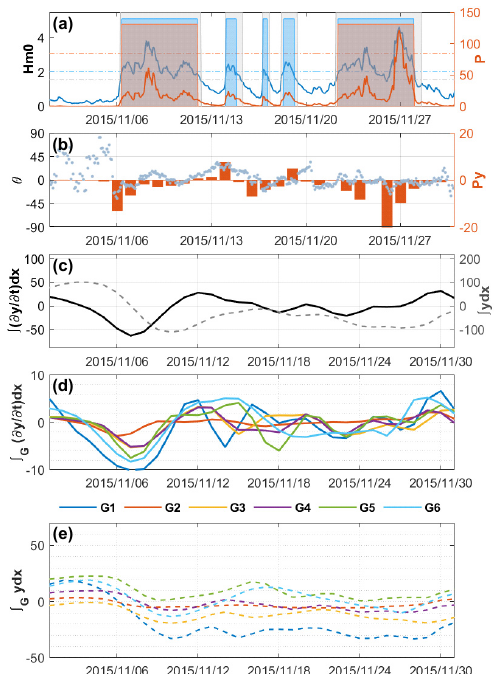
Figure 11. Changes in wave and beach parameters during November 2015. ( a ) Significant wave height and wave power, ( b ) wave direction and longshore component of wave power, ( c ) longshore transport rate (solid line) and integrated beach width (dashed line), ( d ) longshore transport rate for each sector, and ( e ) integrated beach width for each sector. J. Mar. Sci. Eng. 2020 , 8 , x FOR PEER REVIEW